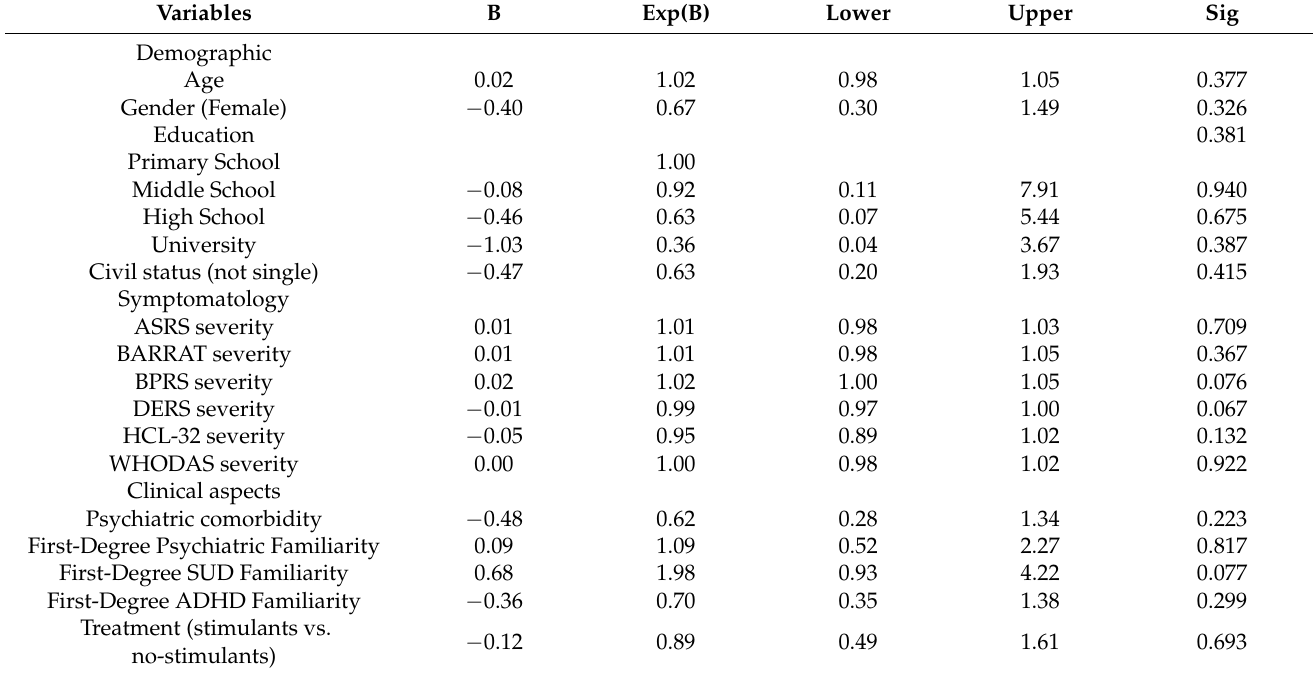
Table 3. Correlation between negative outcome to treatment and associate covariates in 118 A-ADHD study